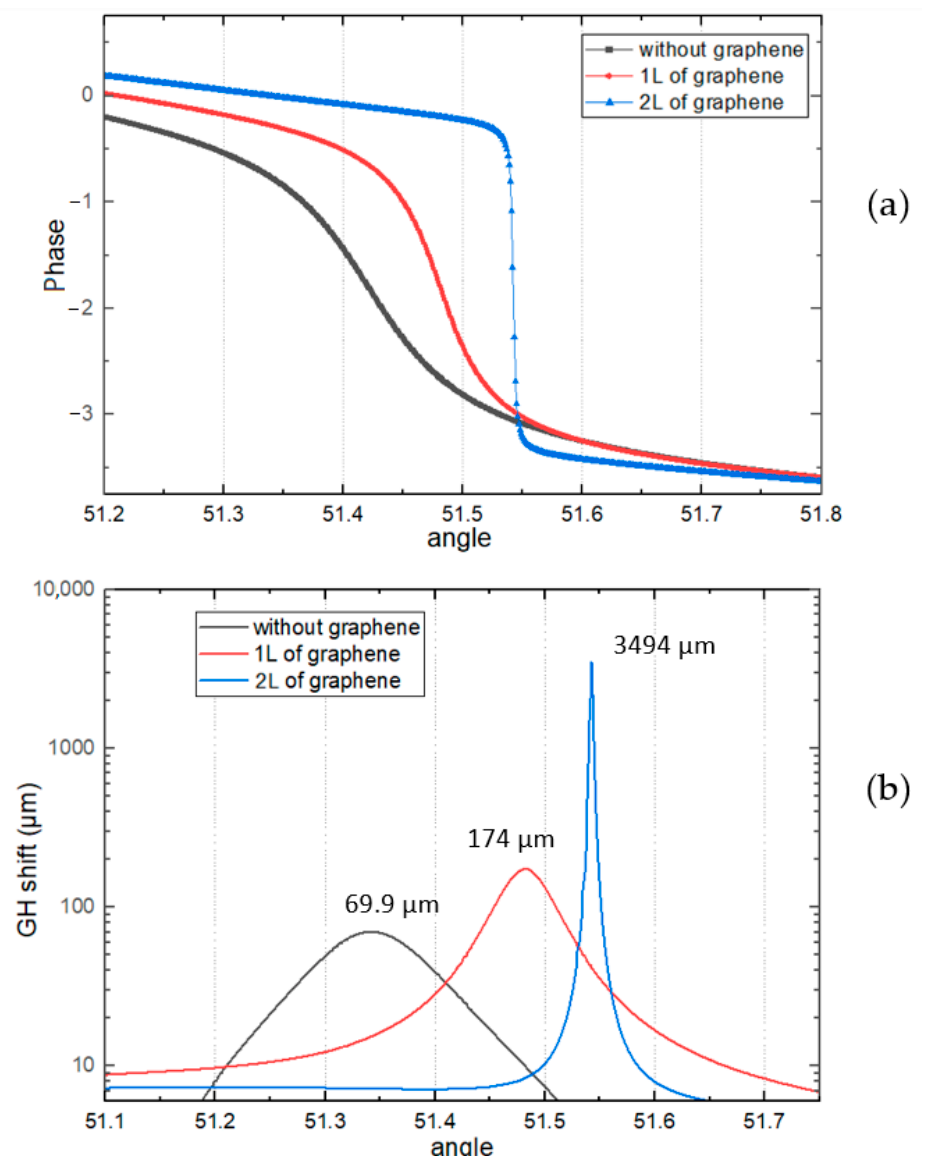
Figure 3. Phase calculations ( a ) and GH shift values ( b ) of the structure with 5 layers of WSe 2 and 35 nm of Cu depending on the angle of incidence (degrees).